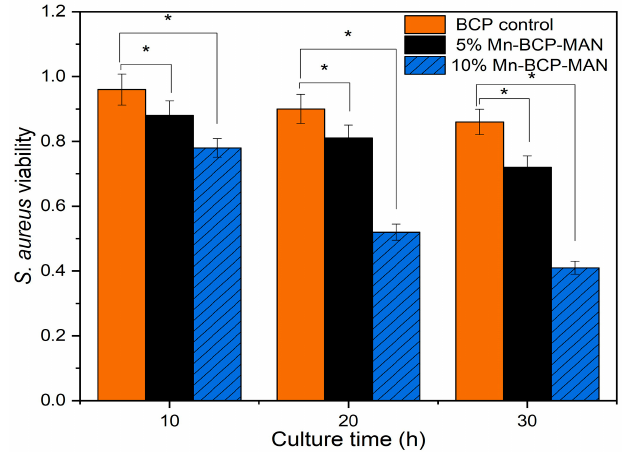
Figure 14. Viability of Staphylococcus aureus on the scaffolds; * denotes p < 0.05.